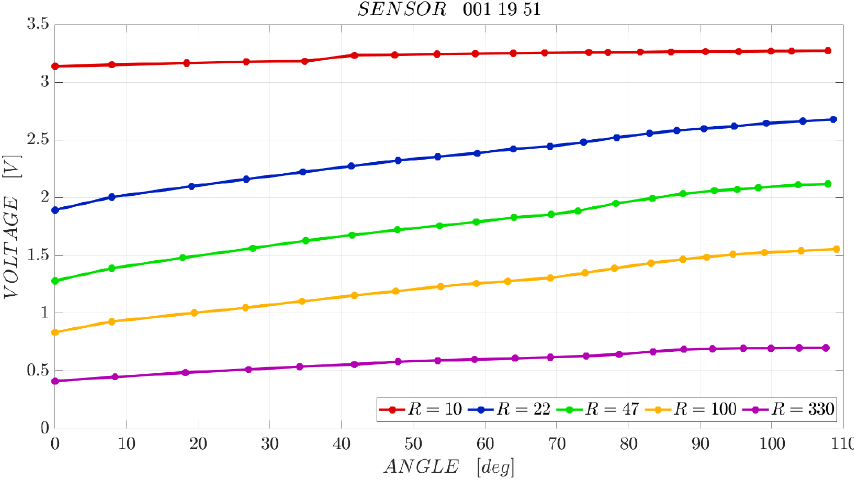
Figure 16. Example of resistance dimensioning for a sensor.